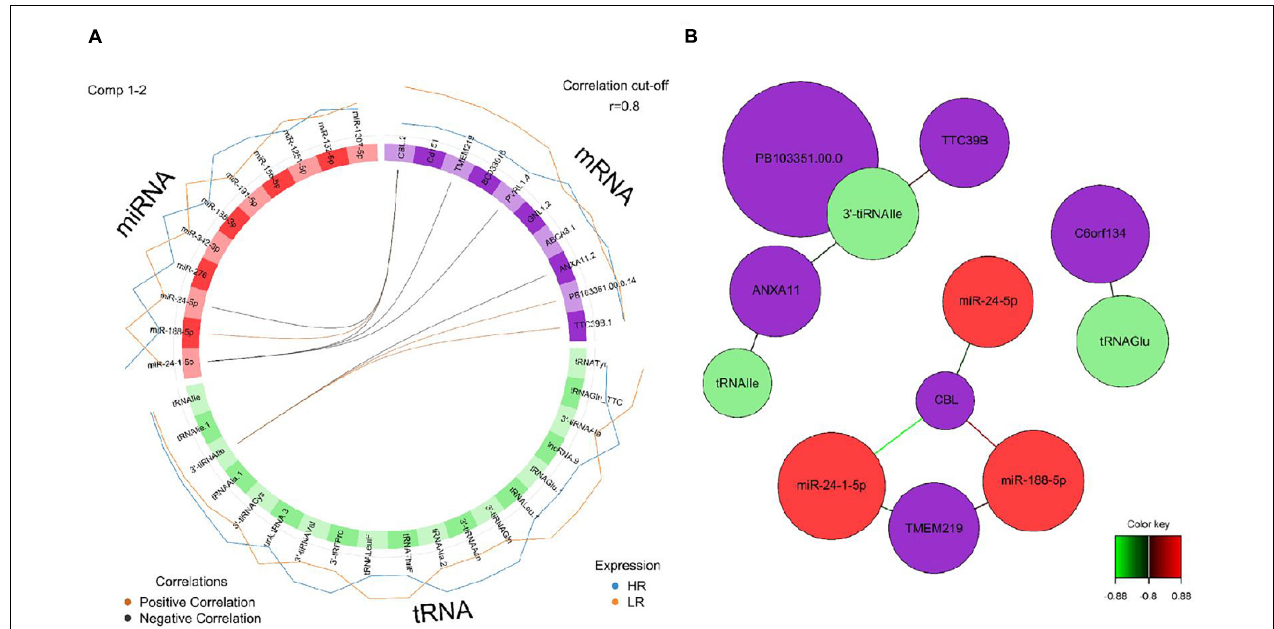
FIGURE 9 | (A) Circos plot of mRNA, miRNA, and tRNA linked to coping behavior haplotype groups in the hypothalamus. Positive correlations are indicated by brown-colored connectors, while black connectors indicate negative correlation between mRNA, miRNA and tRNA. Blue and orange colored lines in the outer circle highlight expression levels in either high (HR) or low (LR) reactive coping group. (B) Network visualization of mRNA, miRNA, and tRNA panels indicating correlated variables in the hypothalamus ( r > | 0.80|). Purple colored nodes represent mRNA, red nodes indicate miRNA and green nodes highlight tRNA biomarkers. Correlation between nodes is indicated by edge color as shown in the color key. Negative correlation is depicted by green edges, while red edges represent positive correlation.